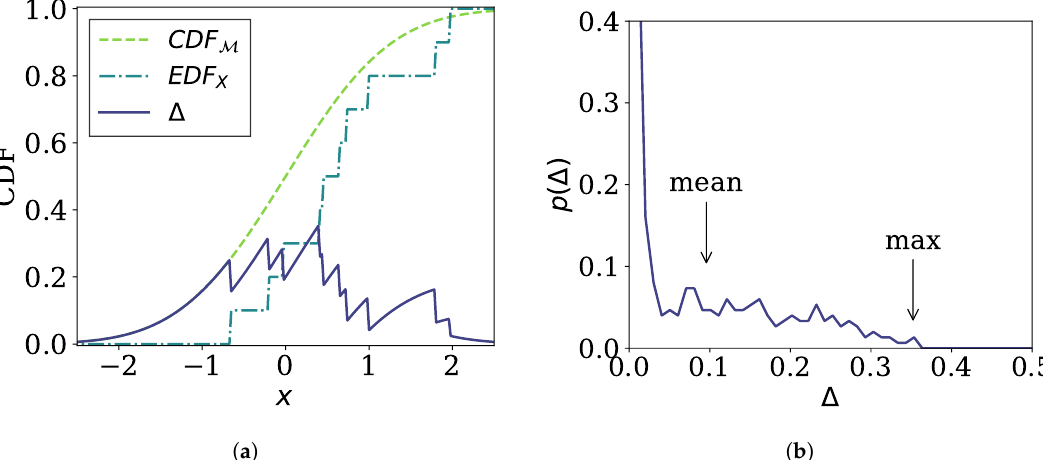
Figure 2. Example of the error function. ( a ) The error function is given as the difference (solid line) between the cumulative distribution function (CDF) of a model (dashed line) and the empirical distribution function (EDF) of a sub-stream (dash-dot line). ( b ) The probability density function (PDF) for the value of the error